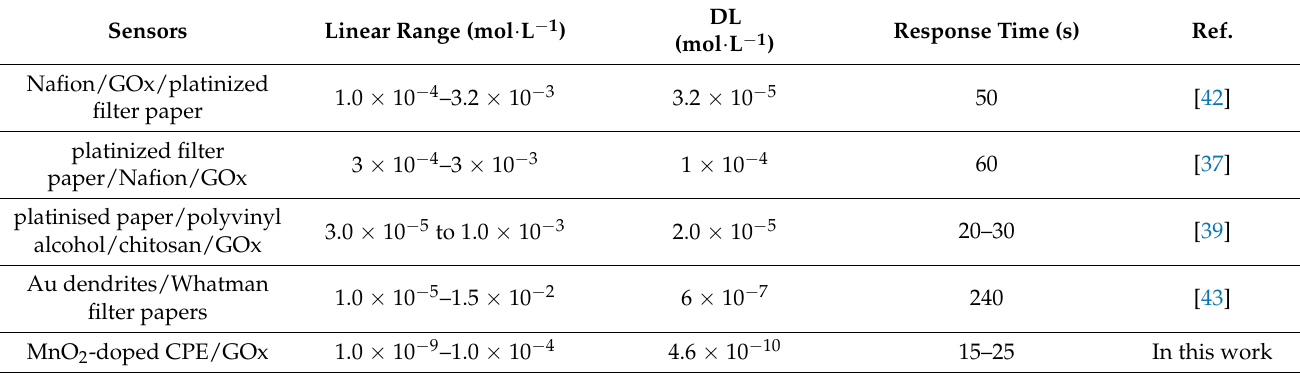
Table 3. A comparison between this work and several electrochemical ePADs for measurement of glucose.